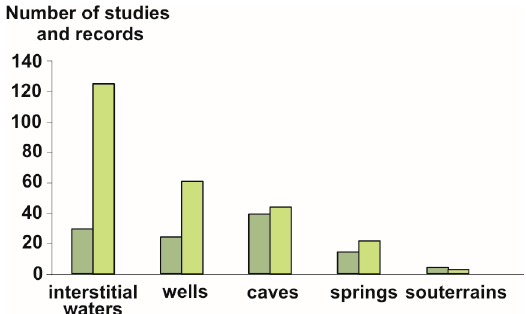
Figure 4. Number of studies performed in particular habitats (green bar) and number of records of specialized subterranean species found in them (light green bar) in Poland. From Dumnicka and Galas [23], modified.